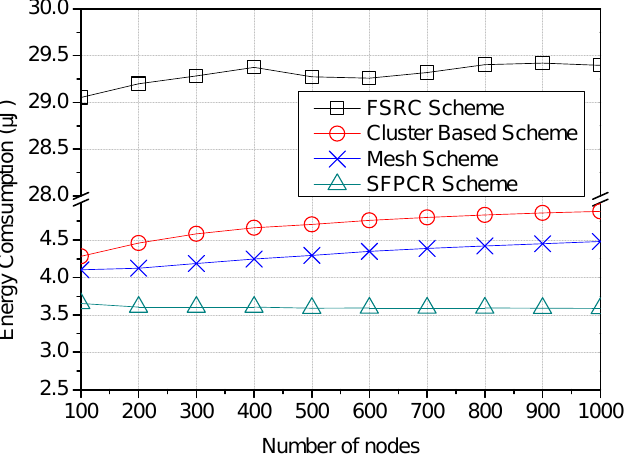
Figure 8. Plots variation of energy consumption ( µ J) as a function of number of nodes with a comparison between the proposed SFPCR scheme and other